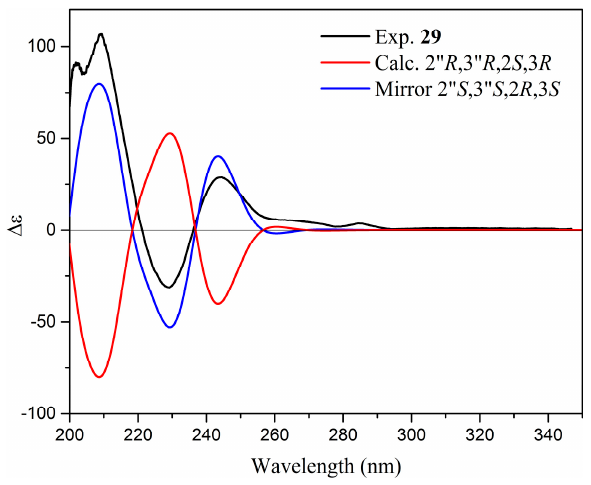
Figure 8. Comparison of experimental and calculated ECD spectra of 29 .